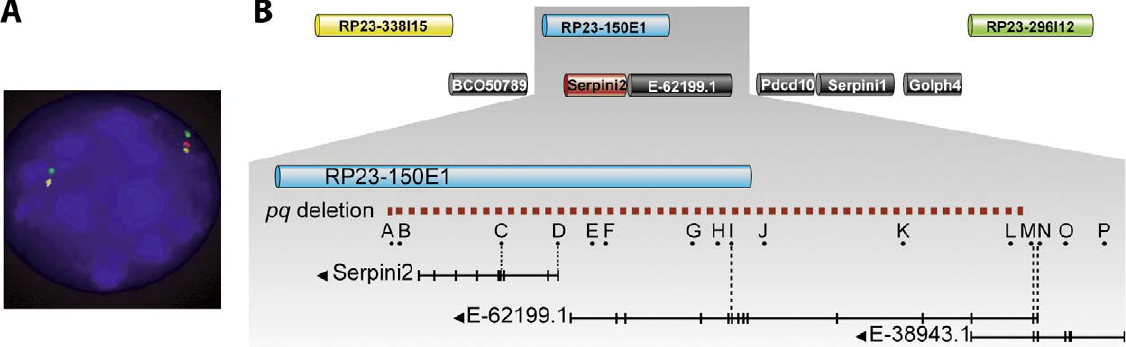
Figure 4. Pequen˜o Phenotype Is the Result of a 210-kb Genomic Deletion (A) FISH to interphase pq/ þ chromosome spreads with a p3pTVA transgene probe (red) locates the transgene insertion on mouse Chromosome 3 between BACs RP23-338I15 (yellow) and RP23-296I12 (green). (B) The genomic region defined by BAC FISH localization contained six known or predicted genes, one of which, Serpini2, is highly expressed in pancreas and adipose tissue. PCR primer sets A–P (Table S1) were used to characterize and define the identified ; 210-kb deletion, indicated by red dashed line. PCR primer sets that correspond to known and predicted exon sequences are indicated by black vertical dashed lines. The genomic deletion encompassed the entire Serpini2 gene locus and exons 4 to 17 of the predicted gene E-62199.1/E-38943.1. DOI: